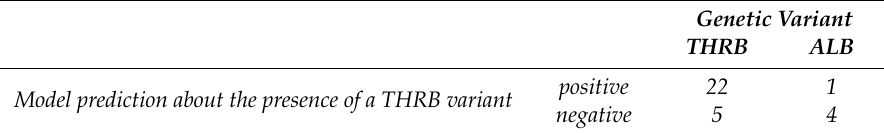
Genetic Variant THRB ALB